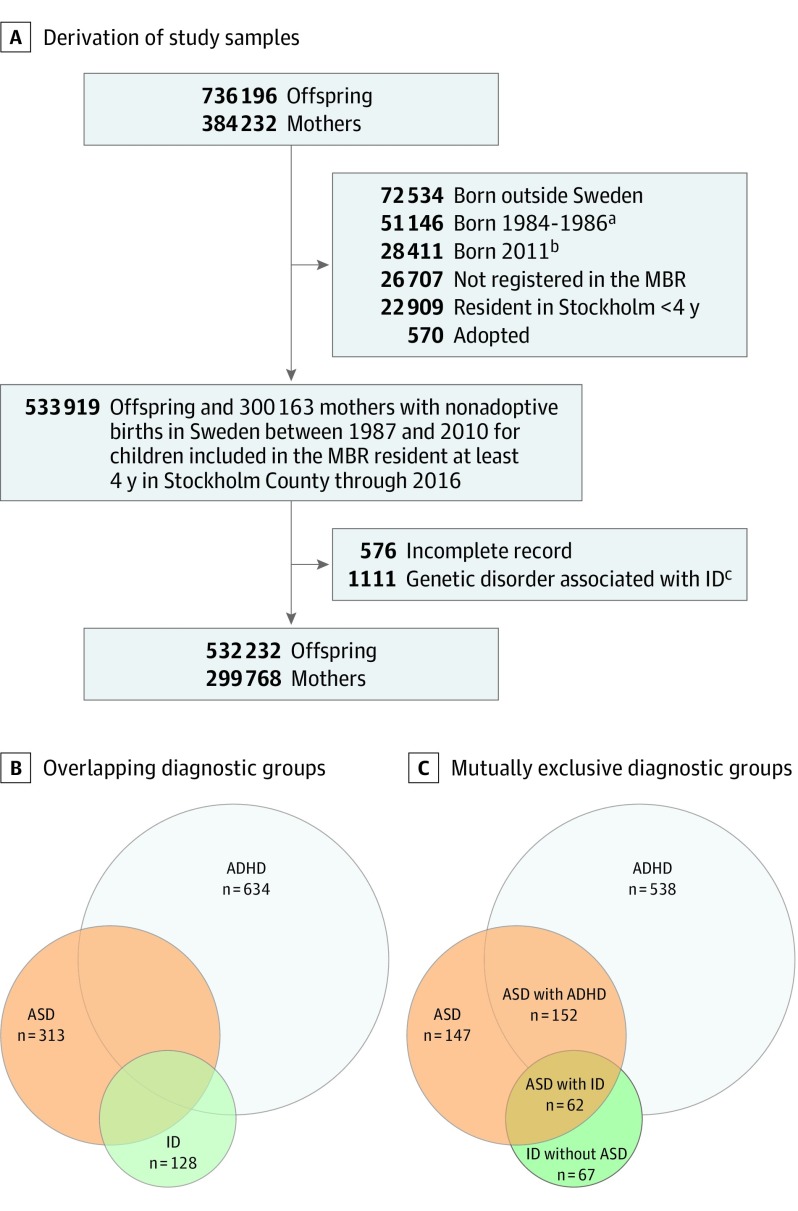
Selection of the Study Population and Characterization of Outcomes in the Stockholm Youth CohortLess prevalent outcomes (ie, individuals diagnosed with intellectual disability [ID] and attention-deficit/hyperactivity disorder [ADHD] but not autism spectrum disorder [ASD] and individuals diagnosed with all 3 diagnoses) were not considered individually because of insufficient power in these groups. Numbers in panels B and C are cases per 10 000 in the study cohort.aLess than 1% of mothers were diagnosed with anemia from 1984 to 1986, and we excluded people born before 1987 as a result.bRecords in the medical birth register (MBR) for individuals born in 2011 were not included in the data linkage for this cohort, and thus we excluded these individuals.cDiagnosed with a known congenital disorder or an inborn error of metabolism that has been associated with intellectual disability.